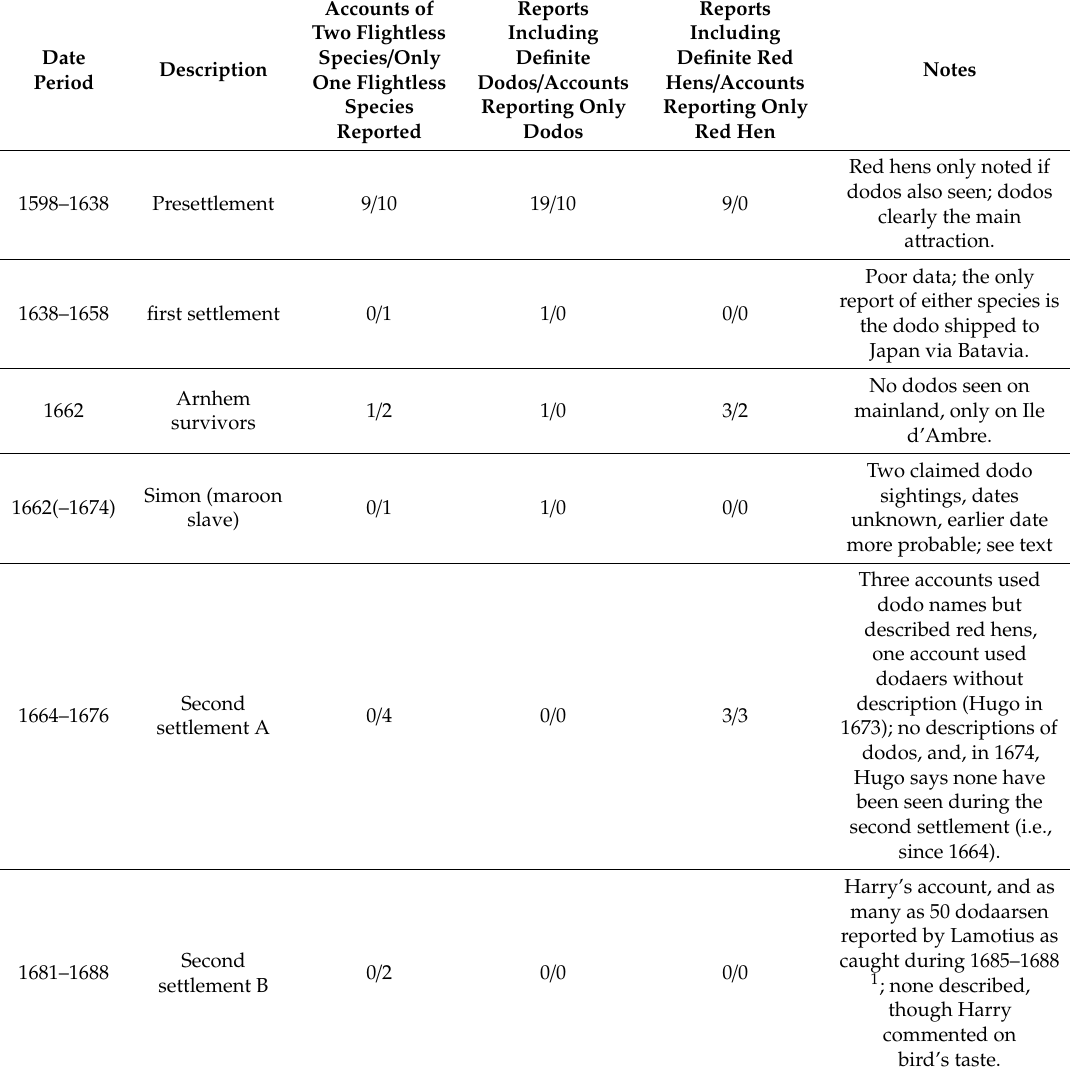
Table A2. Dodo and red-hen record distribution in five historical time periods from first Dutch landing to